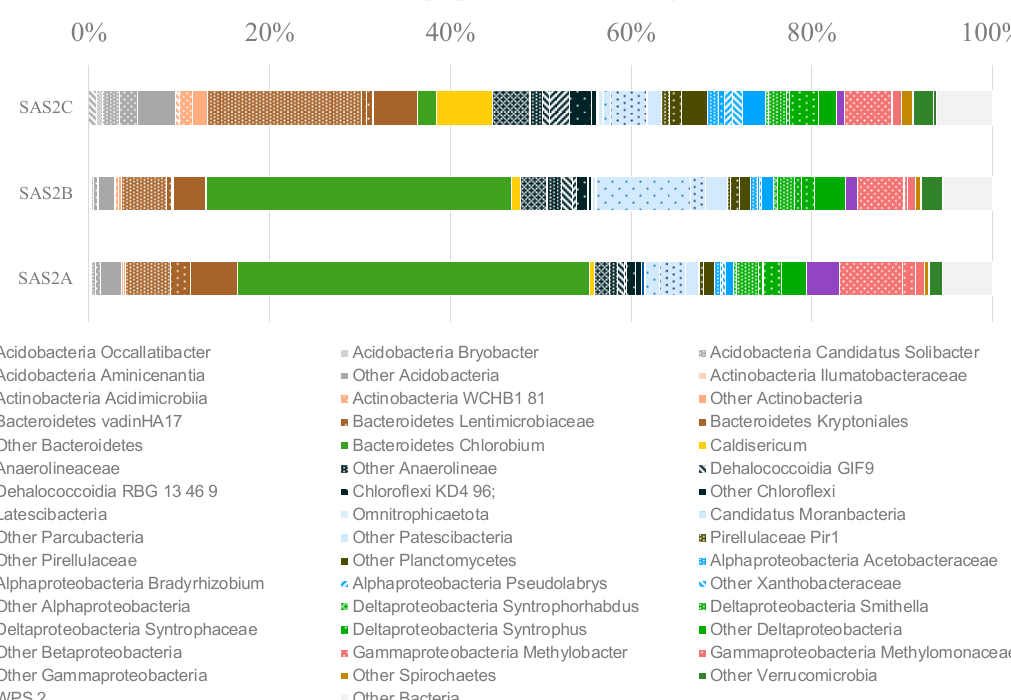
Table 1. Main properties of strains isolated from SAS2A, SAS2B, and SAS2C sampled sites. Sample Medium